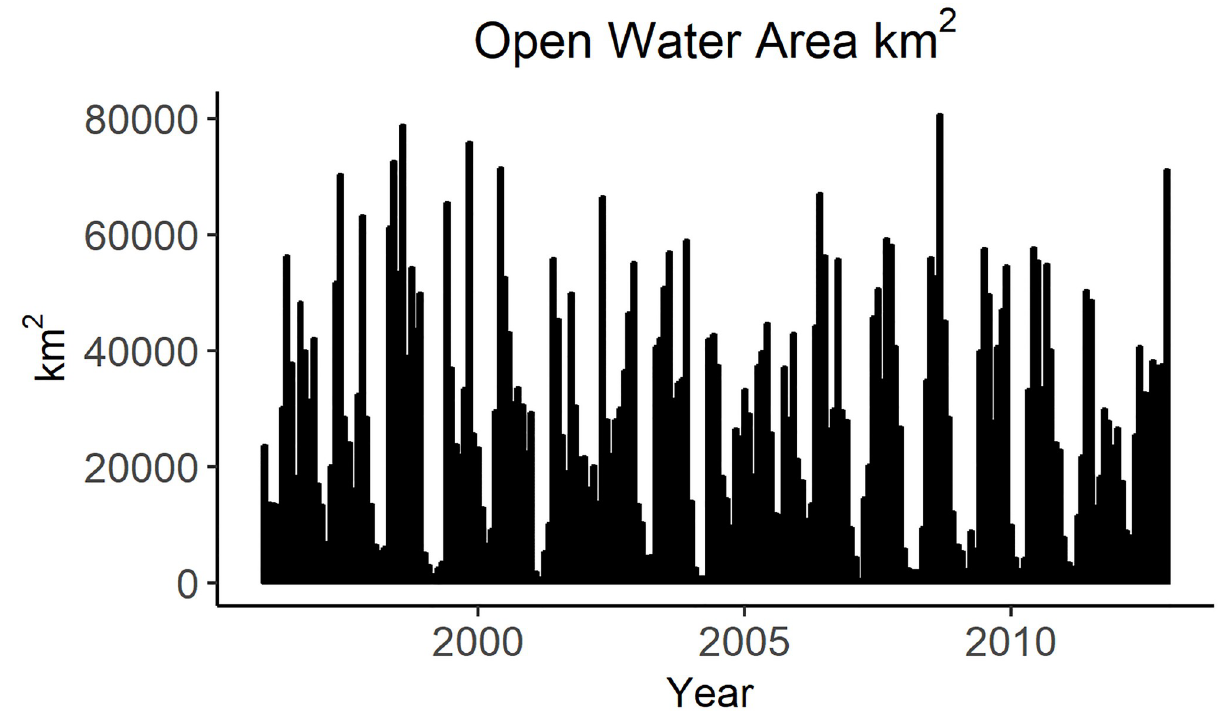
Fig 4. Open water area as documented by the Palmer LTER.